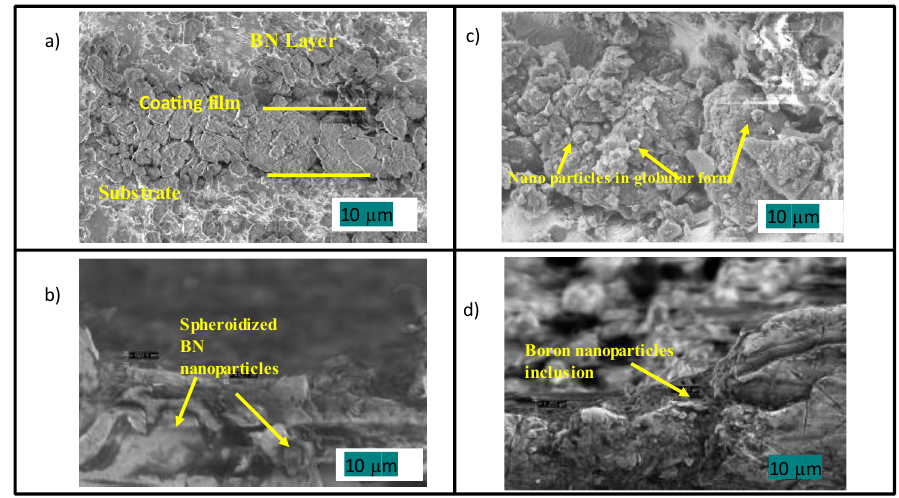
Figure 12. The SEM images of treated pins. ( a ) SEM of sample pin 7, ( b ) SEM of sample pin 8 ( c ) SEM of smaple pin 9, ( d ) SEM of sample pin 19.